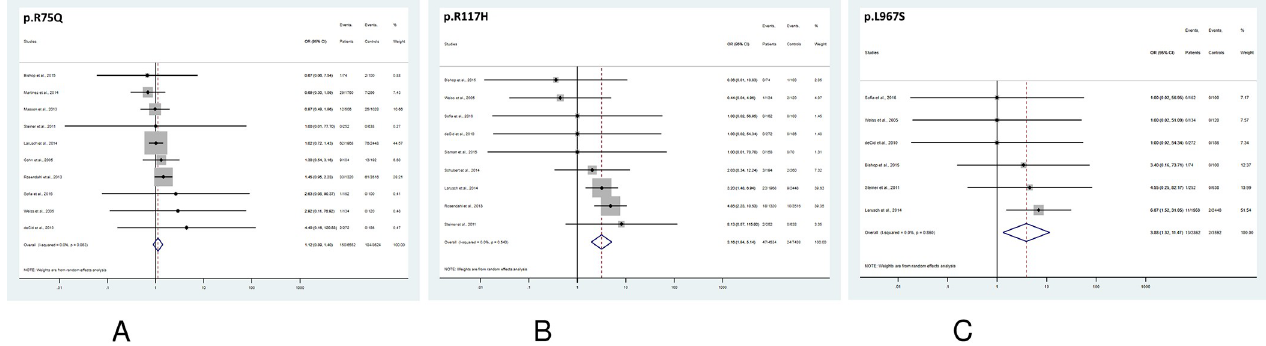
Fig 3. Forest plot showing odds ratios for chronic pancreatitis risk in subjects with CFTR variants. A, p.R75Q; B, p.R117H; C, p.L967S. OR, odds ratio; CI, confidence interval.